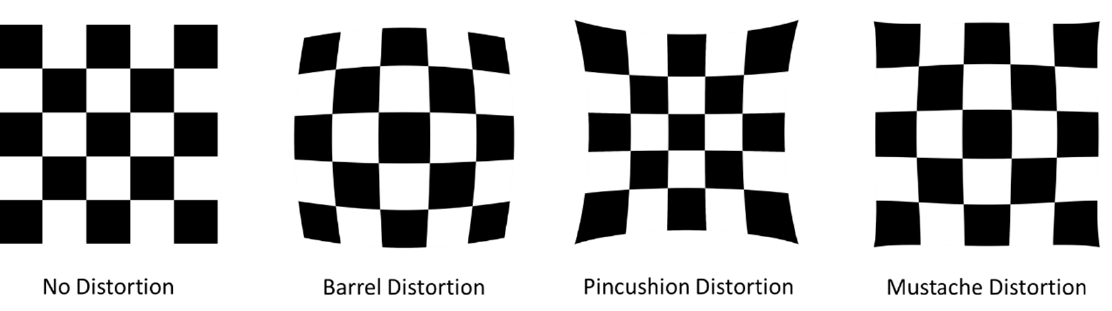
Figure 14. Types of lens distortion [34].